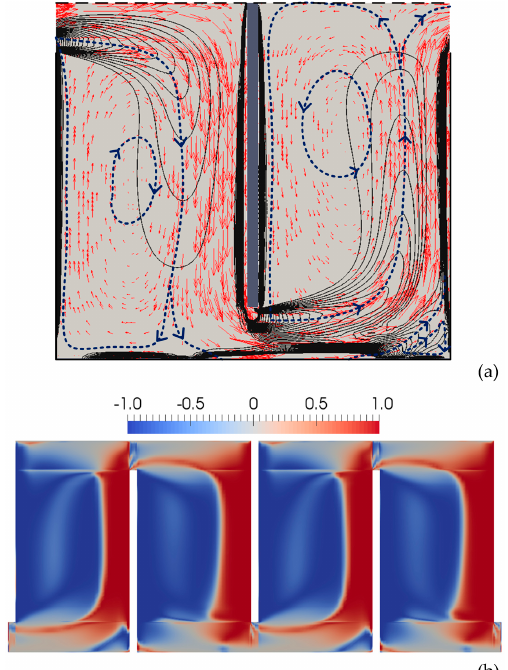
Figure 9. Visualization of streamline patterns and vorticity field on the x–y plane at mid span ( z = L /2) for RANS: ( a ) dimensionless velocity vectors and vorticity contours. The dashed line corresponds to the separation layers; ( b ) Separated boundaries of the jet region using vorticity gradient for a vertical cross section.